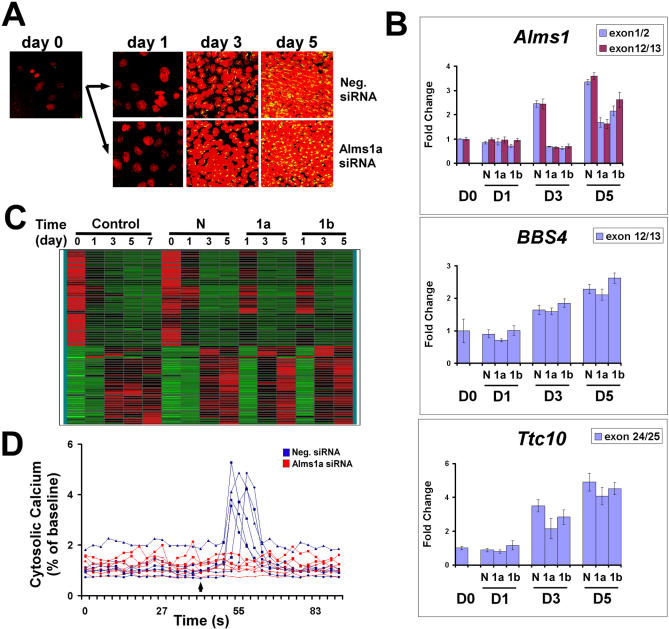
Loss of Alms1 Does Not Affect Transcriptional Changes during Ciliogenesis but Causes Impairment in Flow-Induced Mechanosensation(A) Confocal microscopic analysis of cilia biogenesis in mIMCD3 cells. Short cilia can be detected at day 3 after transfection. mIMCD3 cells transfected with Alms1a siRNA have stunted cilia at days 3 and 5. Cells were stained with anti-acetylated tubulin (yellow, cilia) and TO-PRO-3 (red, nuclei).(B) Suppression of Alms1 does not affect the upregulation of Bbs4 and Ttc10 during ciliogenesis. N, negative siRNA; 1a, Alms1a siRNA; 1b, Alms1b siRNA.(C) Heat map representation of microarray analysis of mIMCD3 during ciliogenesis. 98 genes with the most dramatic changes in expression showed approximately equivalent expression changes in the presence of a scrambled siRNA control, or in the presence of specific siRNAs that decreased Alms1 mRNA levels and blocked cilia formation.(D) Stunted cilia formed in the presence of Alms1a siRNA (red) lack flow-induced Ca2+ influx in mIMCD3 cells, compared with a negative control siRNA (blue). Representative data are shown for cytosolic calcium change of individual cells in response to mechanical flow. Arrow points to the start of flow.